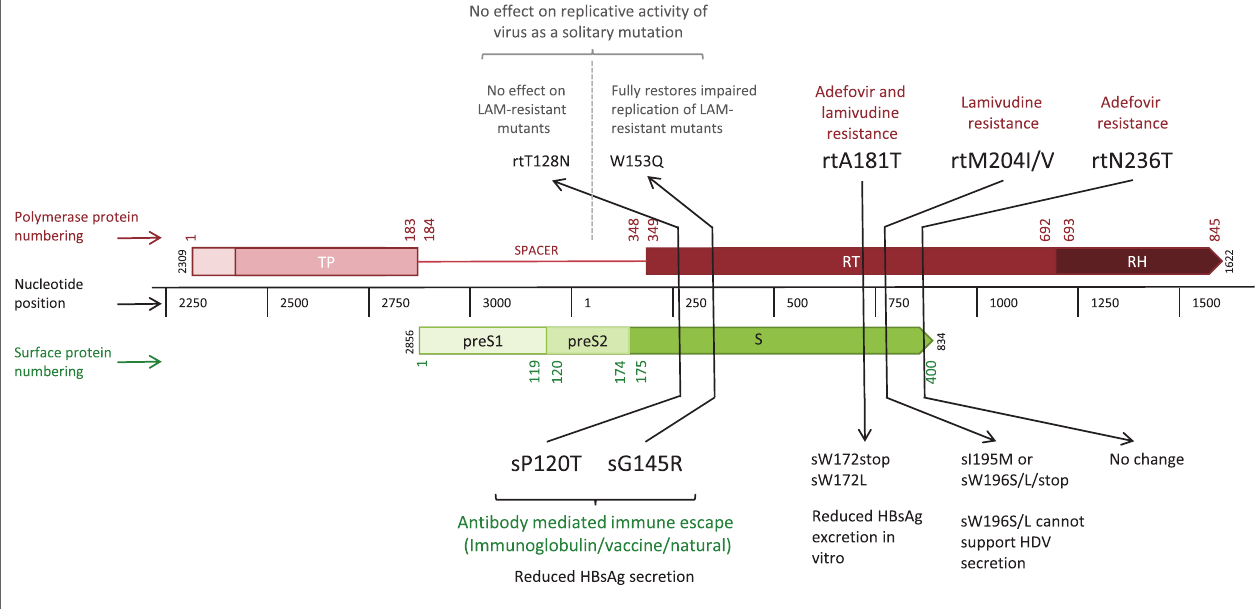
FigURe 2 | Linear depiction of overlapping reading frames of the Polymerase (P) and Surface (S) genes, highlighting five “mirror mutations” (4) where a nucleotide substitution influences amino acids in both S and P proteins. Gene lengths are given in nucleotides (black central bar); protein numbering based on the HBVdb X02763 amino acid sequence (7) is shown in color (Polymerase in red, Surface in green) for the whole protein. Mutations are given in amino acid positions in the affected gene segment, with the mutations in bold indicating the primary mutation with functional effect, and those in regular text indicating the secondary mirror mutation with any incidental functional